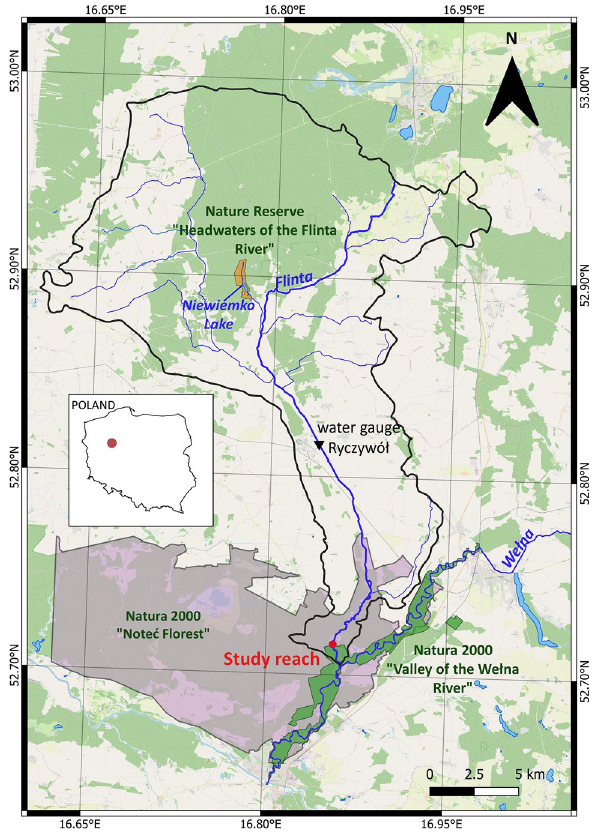
Figure 1. Location of the Flinta River catchment and the study river reach. This original map was created using QGIS 3.20.2 (https:// downl oad. qgis. org/ downl oads/). The layers of rivers, lakes and the Flinta River catchment were obtained from the State Water Holding Polish Waters (https:// dane. gov. pl/ pl/ search? q= MPHP), layers of protected areas were obtained from the Regional Directorate for Environmental Protection in Warsaw (http:// warsz awa. rdos. gov. pl/ dane-i- metad ane), and the base map was the OpenStreetMap (https:// www. opens treet map. org/# map=7/ 52. 012/ 16.